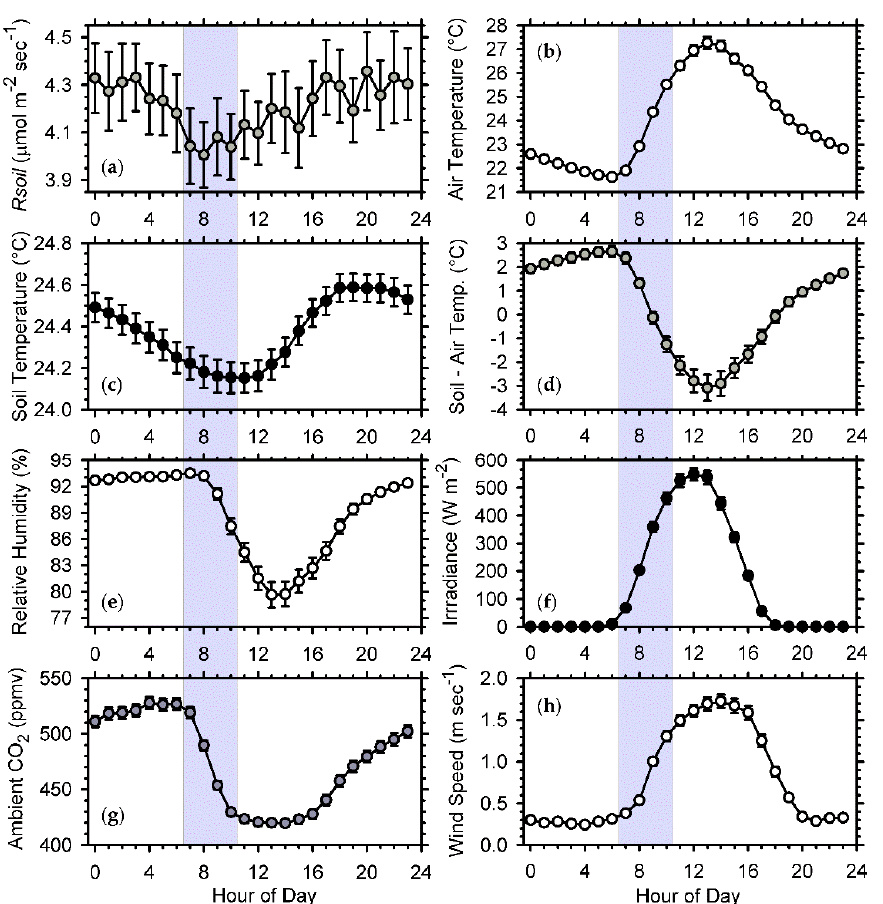
Figure 2. Observed diel variability in ( a ) soil respiration ( Rsoil ) was significant, but inconsistent ( R 2 = 0.02), whereas the variability in potentially controlling environmental variables was pronounced. The shaded hours highlight the period between 06:30 and 10:30 when Rsoil was lowest on average; ( b ) Mean surface air temperatures; ( c ) soil temperatures at 10 ‐ cm depth; ( d ) the difference between air and soil temperatures; ( e ) atmospheric relative humidity and ( g ) ambient atmospheric CO 2 concentration were all measured in situ, with Rsoil . Shown are means (±S.E.) of each variable, based on all diel measurement dates and times; ( f ) Solar irradiance and ( h ) mean wind speeds were measured at the La Selva weather station, about 3.5 km from the field sites; the data included here were temporally synchronized with the diel measurements.